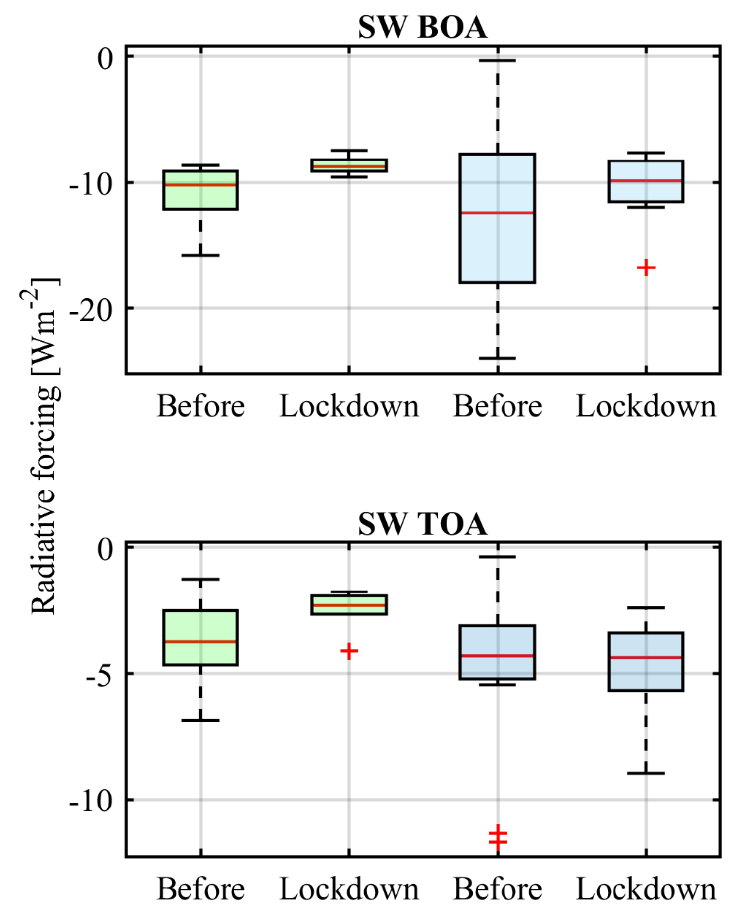
Figure 5. Boxplot of the aerosol radiative forcing in the SW spectral range estimated at the BOA (upper figure) and at the TOA (lower figure) for the morning (green boxes) and afternoon (blue boxes) before and during lockdown cases. Red lines inside the boxes stand for the median value in each scenario, the lower and upper limits of each box represent the 25th and 75th percentile respectively and black horizontal lines extend to the most extreme radiative forcing estimates not considered outliers. Red crosses represent the radiative forcing estimates considered as outliers.